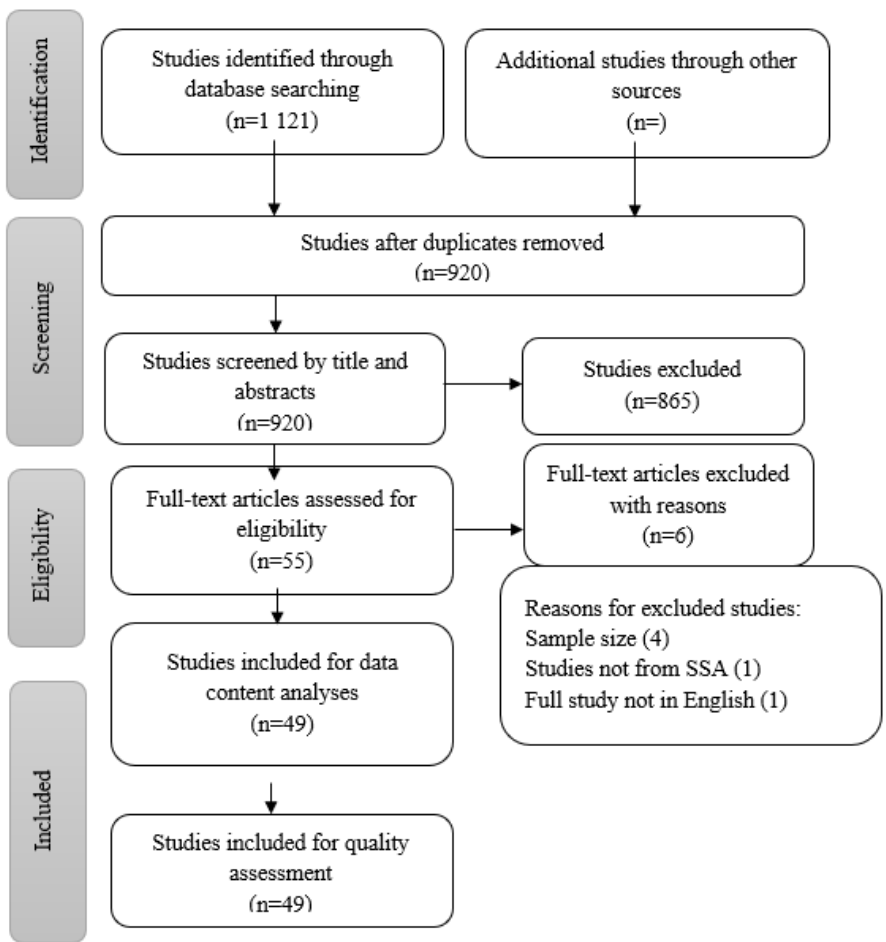
Figure 1. PRISMA flow diagram of the study selection process. Total studies identified 1121 (959 PubMed, 50 Scopus, 100 EBSCOhost, and 12 Cochrane), and effectively 49 remained for the scoping